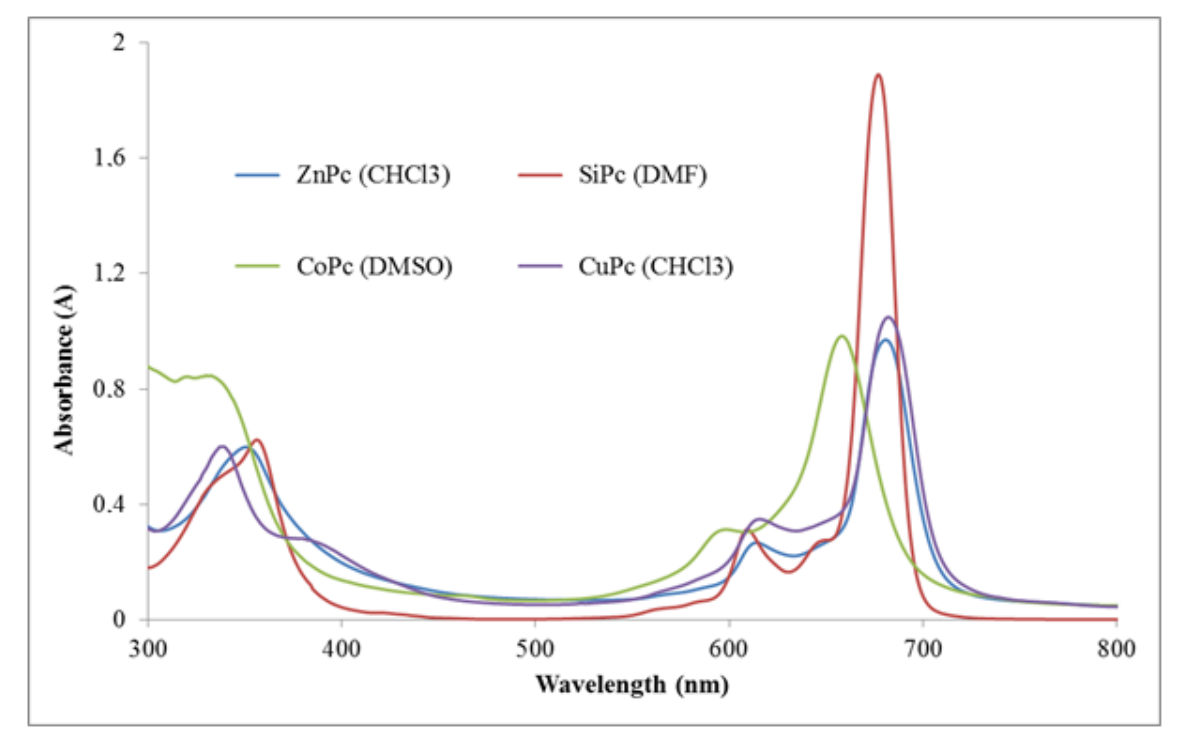
Figure 4. The UV-vis spectrum of MPc derivates (concentration = 1 × 10 − 5 mol/L). As a result of overlapping of B1 and B2 bands, B band is observed as one broadband [34,59]. Before sensitization of TiO 2 , MPc samples were dissolved in a desired solvent at 1 × 10 − 5 mol/L concentration that can utilize their light absorption spectrum in a wide range. Due to steric hindrance of macrocyclic ring of four substituent-linked CoPc, absorbance of CoPc was shown to decrease. Originating from π → π * transitions, Q